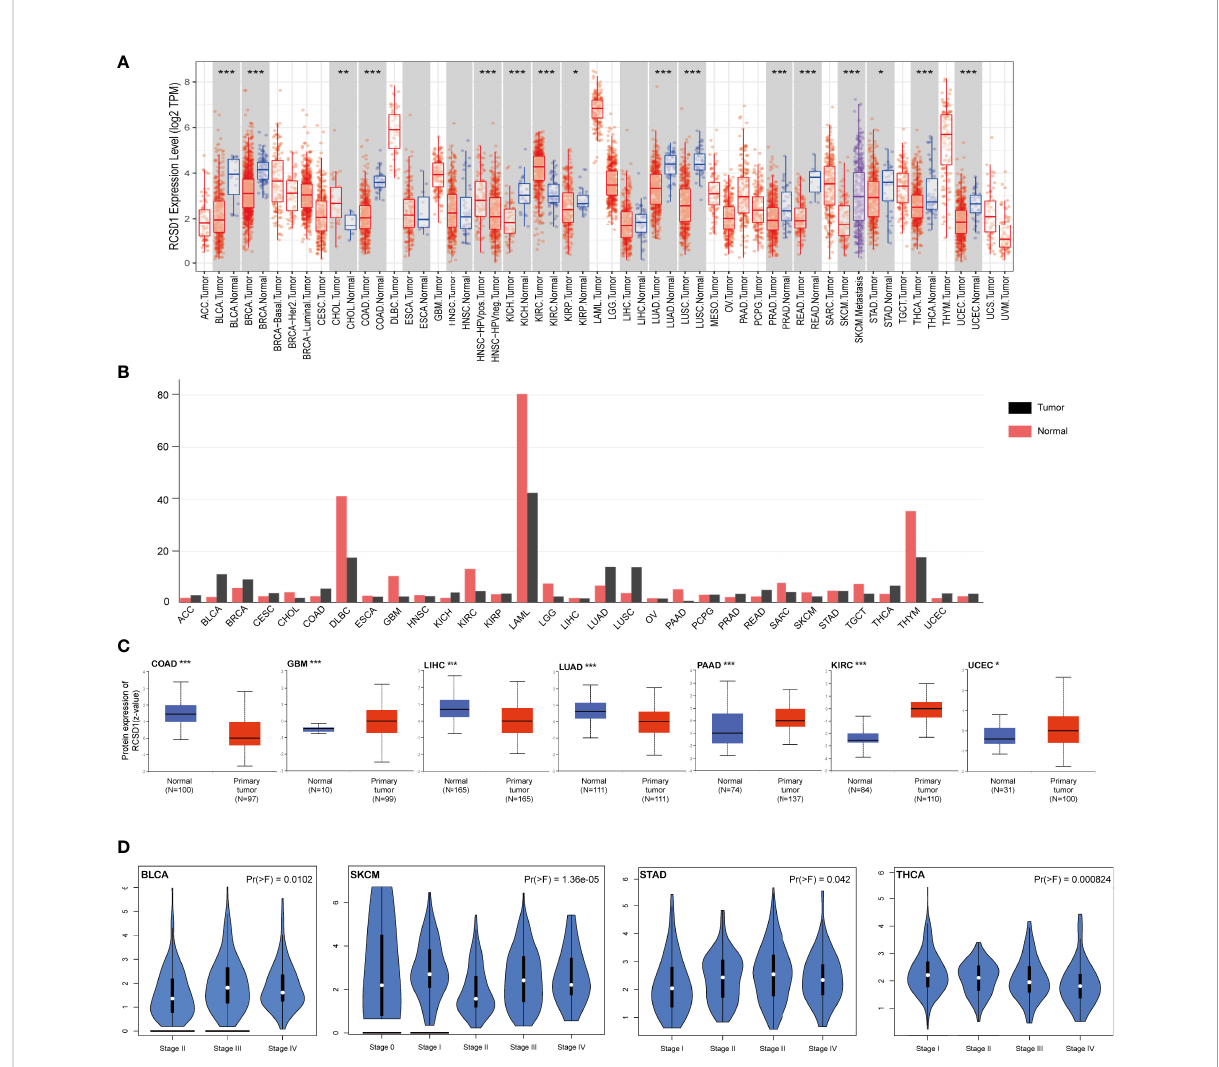
FIGURE 1 Expression level of the RCSD1 gene in different human tumors and pathological stages. (A) Expression status of the RCSD1 gene in different cancer was analyzed by TIMER database. (B) RCSD1 expression level in different cancers veri fi ed using GEPIA database. (C) Expression levels of total RCSD1 protein between normal and primary tissues of COAD, GBM, LIHC, LUAD, PAAD, KIRC and UCEC were extracted and analyzed in the CPTAC dataset. (D) The RCSD1 gene expression levels at the major pathological stages of BLCA, SKCM, STAD, and THCA using GEPIA database. *, P <0.05; **, P <0.01; ***, P